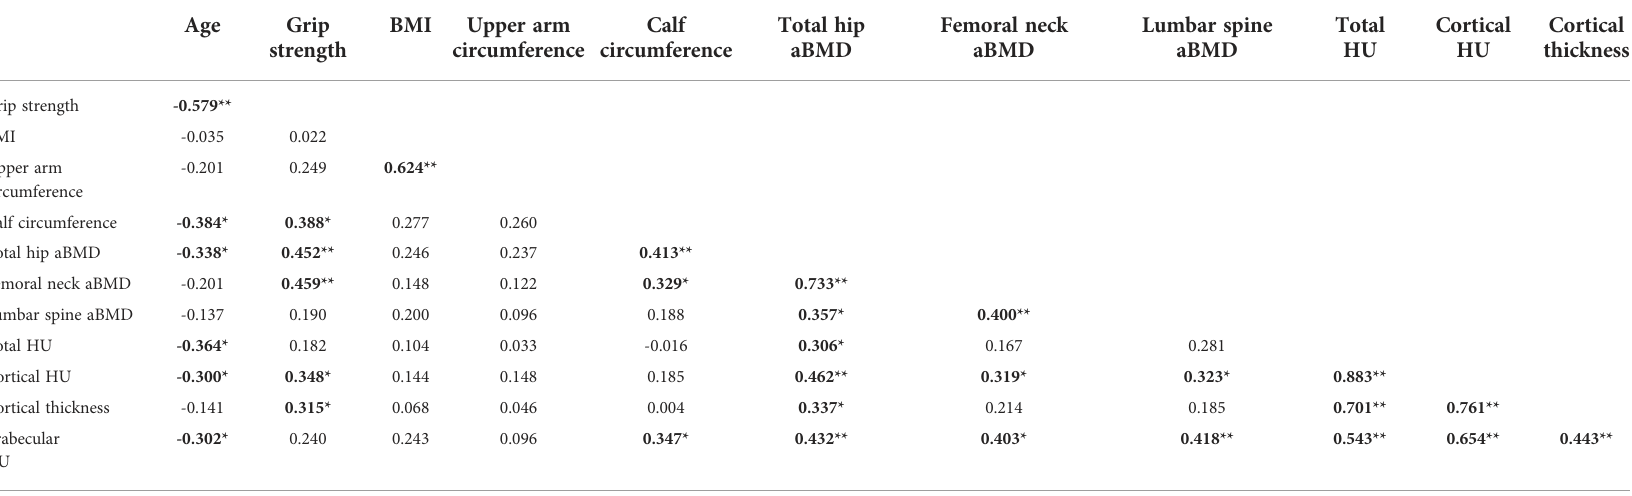
TABLE 4 Correlation coef fi cient among age, handgrip strength, BMI, circumferences of upper arm and calf, aBMD of total hip, femoral neck, and lumbar spine, and local bone quality of radial